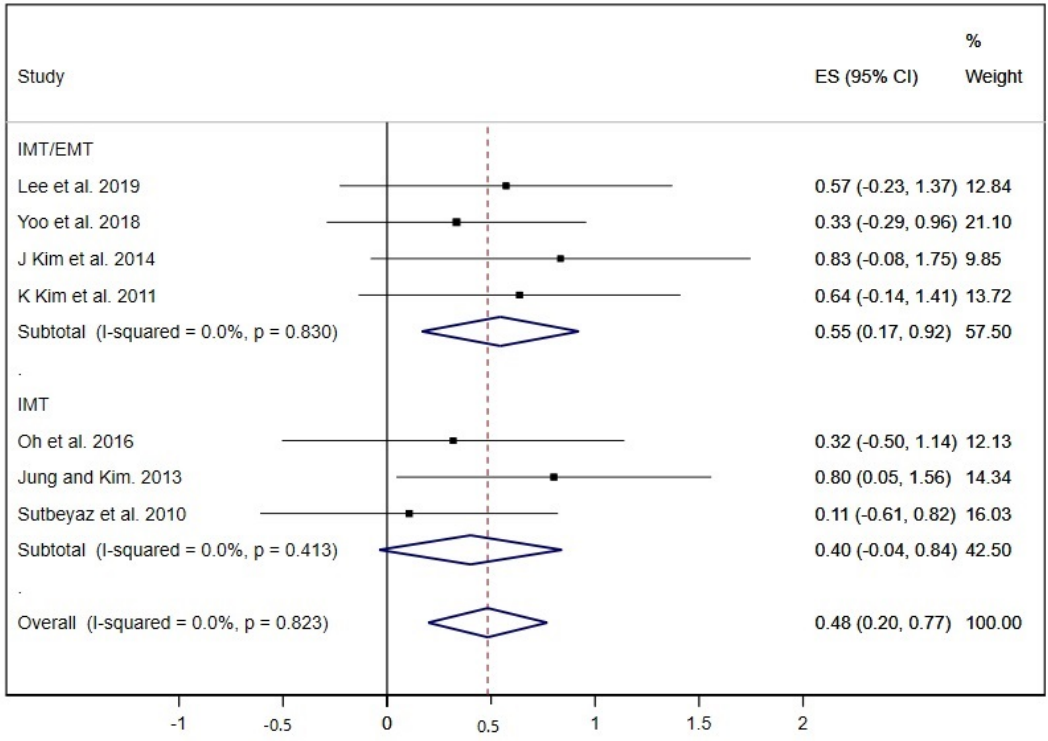
Figure 4. Forest plot showing the e ff ect size (ES) of respiratory muscle training (RMT) on peak expiratory flow (PEF) between intervention and control groups for each study. IMT, inspiratory muscle training; EMT, expiratory muscle training.